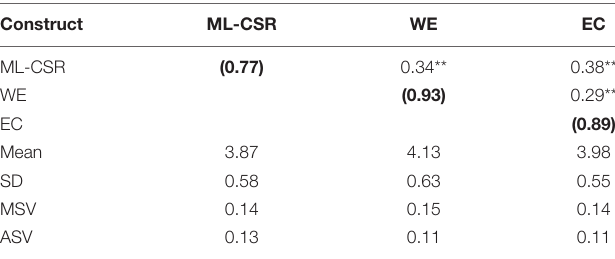
TABLE 3 | Correlation, discriminant validity, and model fit